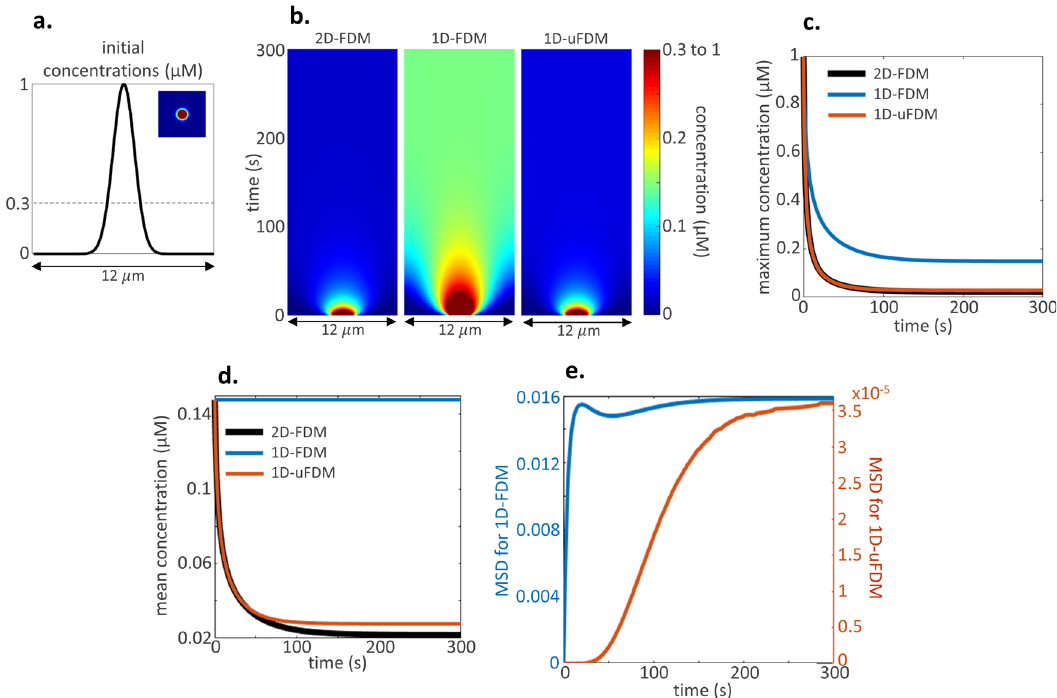
Fig. 2 Illustrative example 1: Diffusion initial conditions and results. a Initial concentrations for diffusion solutions, u 1 D x ; 0 ð Þ ¼ e (cid:2) x 2 and inset u x ; y ; 0 ð Þ ¼ e (cid:2) x 2 þ y 2 ð Þ . The dotted line shows the threshold for colorplots (inset and b ). The threshold was chosen to highlight differences in dynamics and 2 D homogeneous steady states in kymographs. b Kymographs of the 2D solution along a slice through the centre of the initial patch, and the 1D solutions. c Concentration at the centre of the initial patch plotted over time for each solution. In this illustrative example the central concentration is the maximum concentration. d Mean concentration in the 1D solutions compared with the mean concentration of the 2D solution along a slice through the centre of the initial patch. e Mean squared distance (MSD) between the concentrations along a slice through the centre of the initial patch in the 2D solution and the 1D solutions. 1D-FDM comparison is shown in blue, and 1D-uFDM comparison in